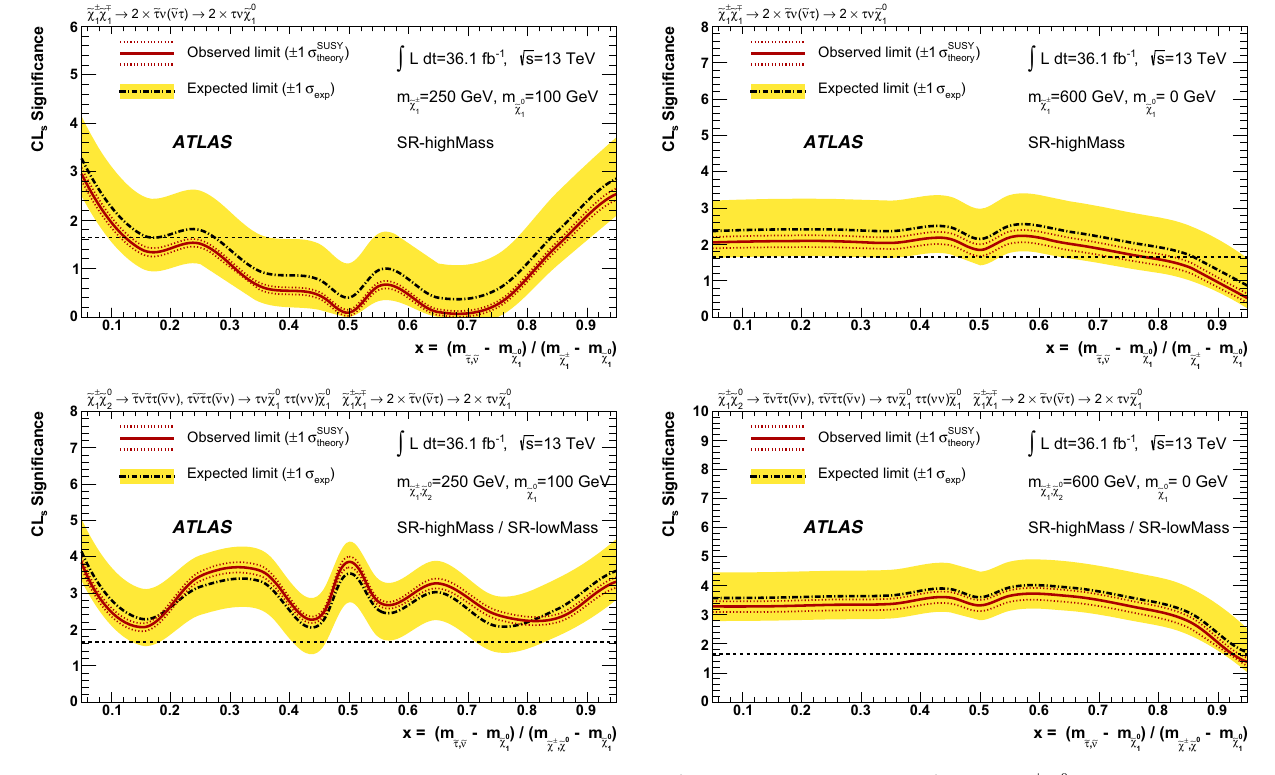
Fig. 8 The CL s significance for the benchmark models described in Sect. 3 as a function of the parameter x . The benchmark sce- nario with large mass splitting ( m ( ˜ χ 0 GeV) is shown on the right, and the compressed benchmark sce- ± ˜ χ 0 nario ( m ( ˜ χ 1 , 2 ) = 250 GeV and m (